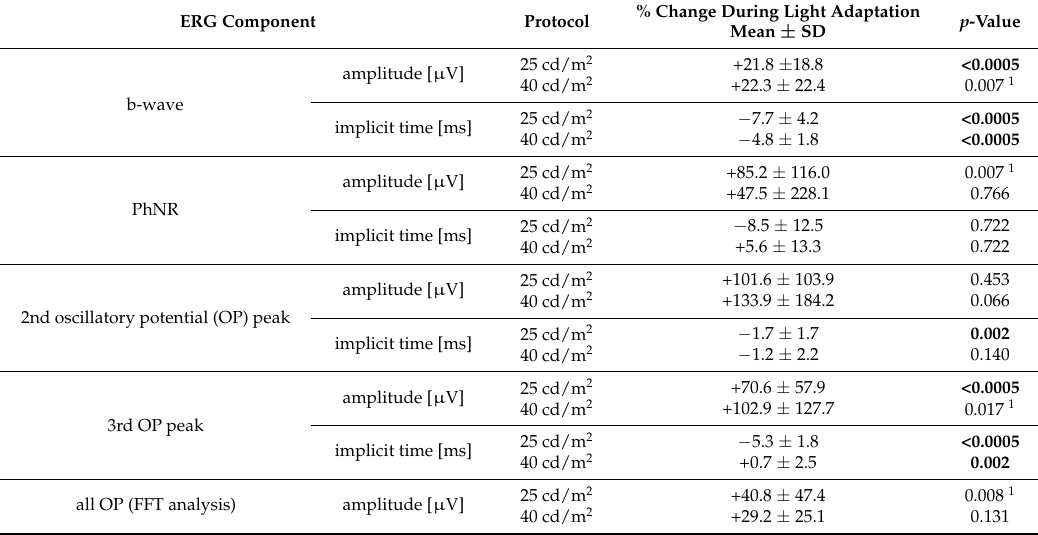
ERG Component Protocol % Change During Light Adaptation Mean ± SD